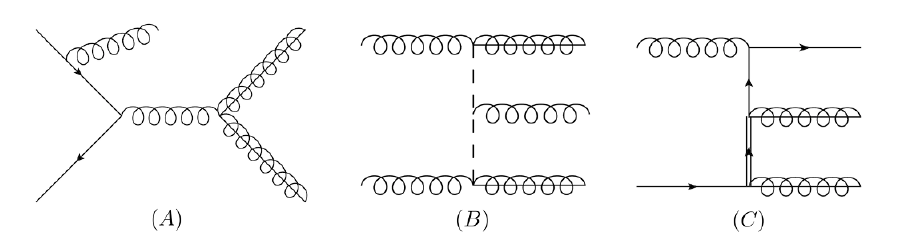
Figure 3 . Sample real radiation diagrams contributing to coloron pair production. See (cid:12)gure 1 for the de(cid:12)nition of the di(cid:11)erent propagator line